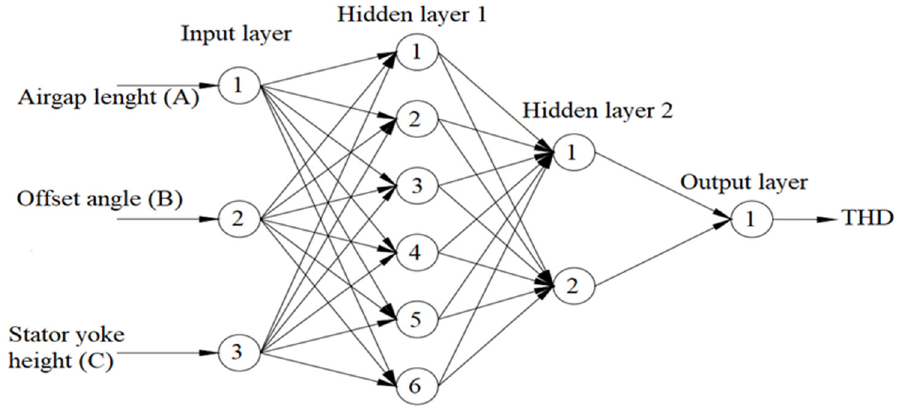
Figure 11. Structure of the Artificial Neural Network (ANN) used in this